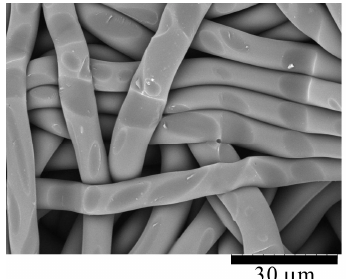
Figure 4. SEM image of an intermediate layer of a CO 2 -assisted polymer compression (CAPC) sample. Traces of fibers pressed on their surfaces are observed.